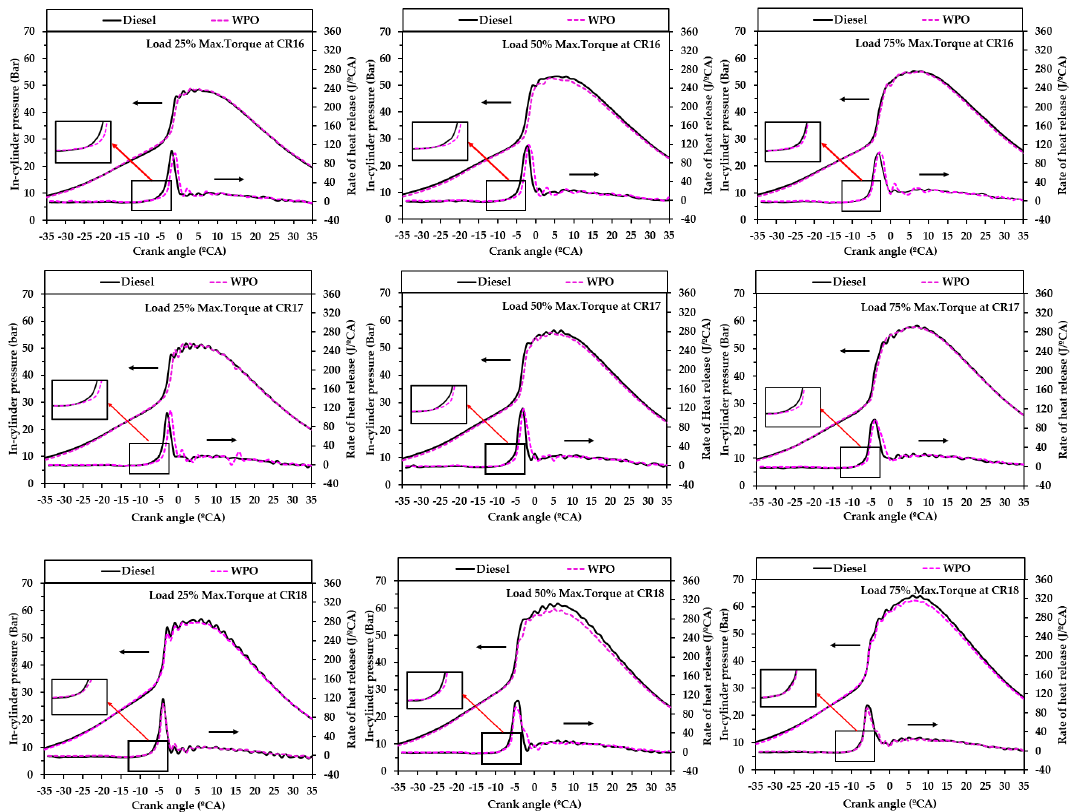
Figure 6. Variation in heat release rate and in-cylinder pressure with the crank angle.